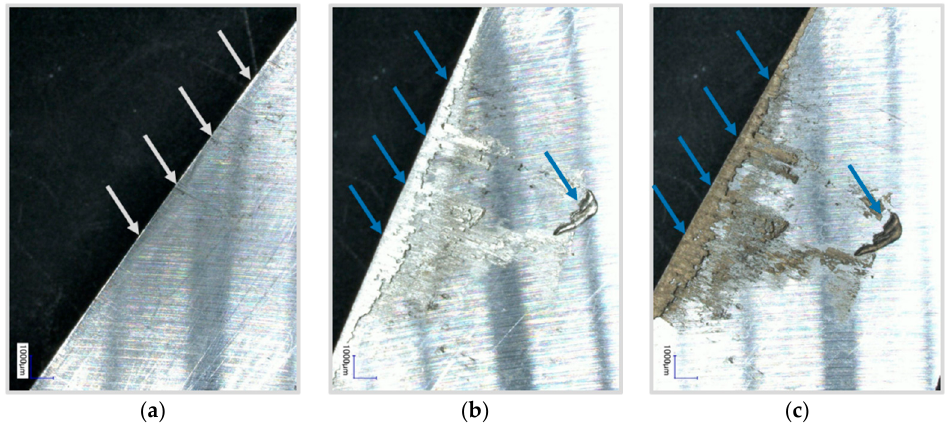
Figure 3. Mechanical cut out. Adhering lithium metal parts are highlighted by the blue arrows. ( a ) Unused cutting tool; ( b ) Cutting tool after 5 cuts; ( c ) Reactions with unconditioned atmosphere.